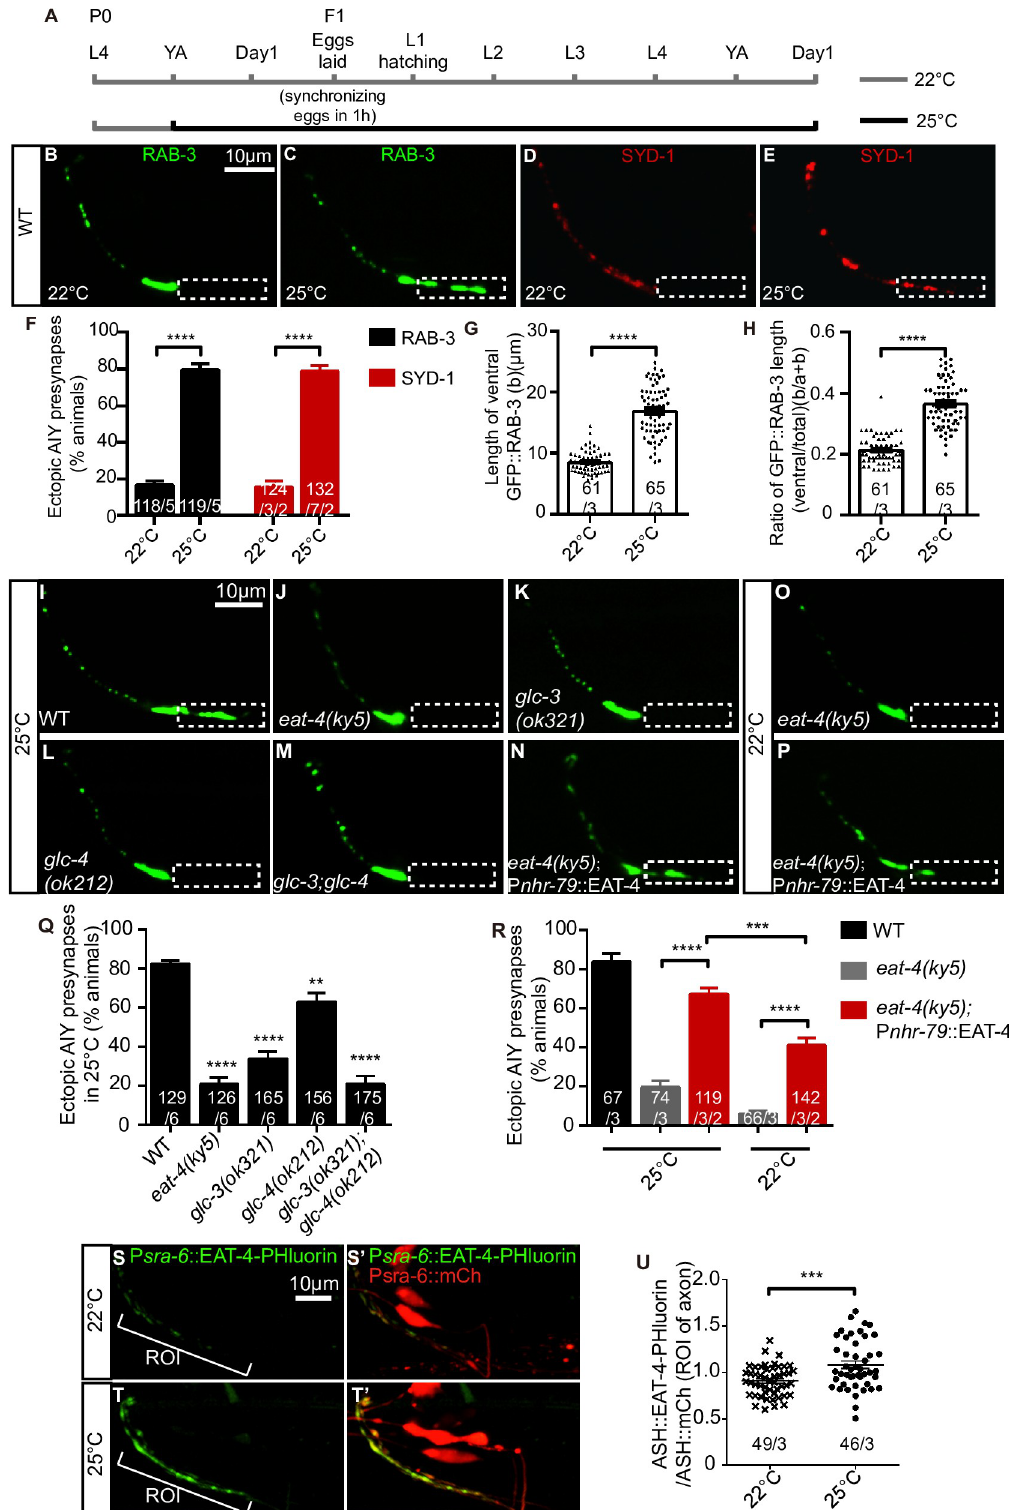
Fig 7. High temperature disrupts the synaptic subcellular specificity mediated by EAT-4, GLC-3 and GLC-4. (A) A schematic diagram shows the cultivation temperature conditions. The control group were cultivated at the constant 22˚C